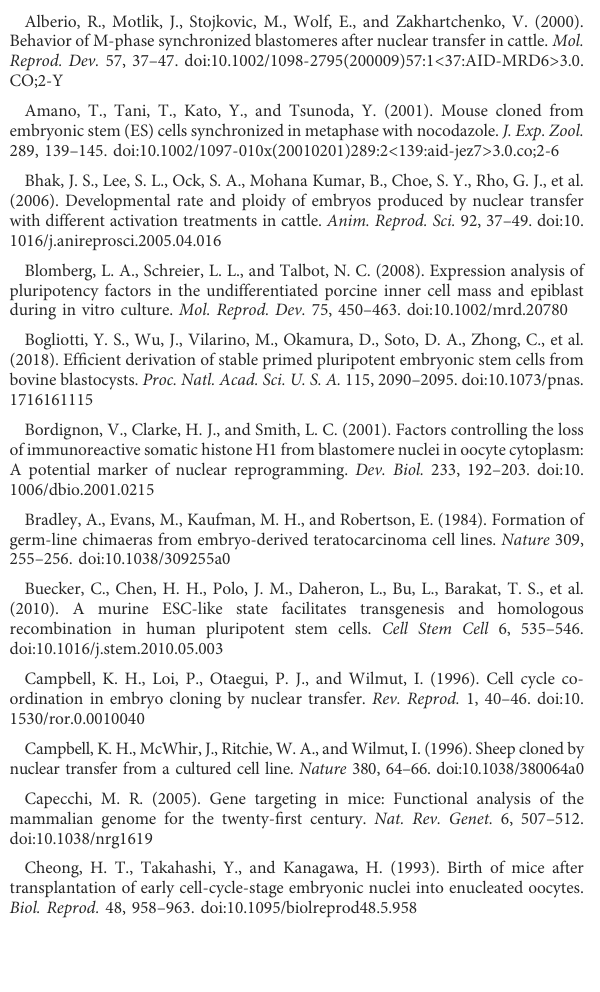
SUPPLEMENTARY FIGURE S3 Optimisation of fusion and activation parameters. (A ) Lysis in hypoosmolarvsisoosmolar fusionbuffer.**=treatmentsdiffer P < 0.01; N= 494 couplets. (B) Effect of pronase in different fusion buffers. ** = treatments in the same buffer differ P < 0.01; N= 611 couplets; error bars = SEM; n = number of replicates; (C-H) Polar body extrusion and in